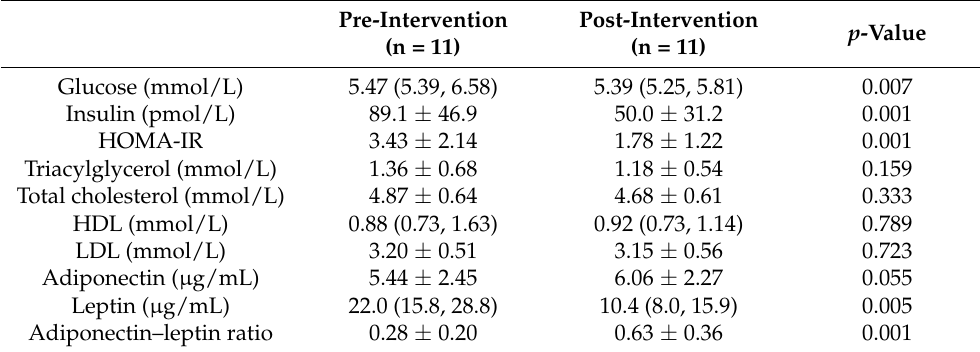
Table 3. Fasting variables before and after the